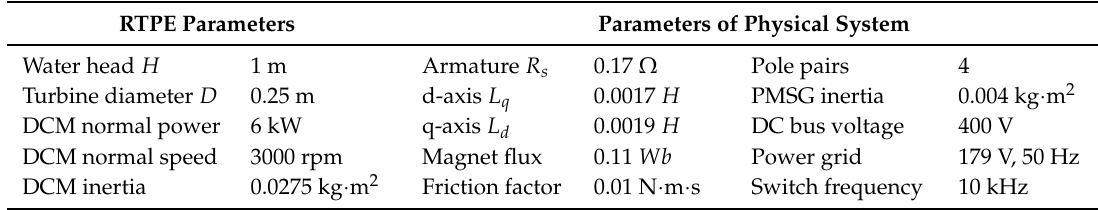
Table 2. Parameters of the PHIL experiment